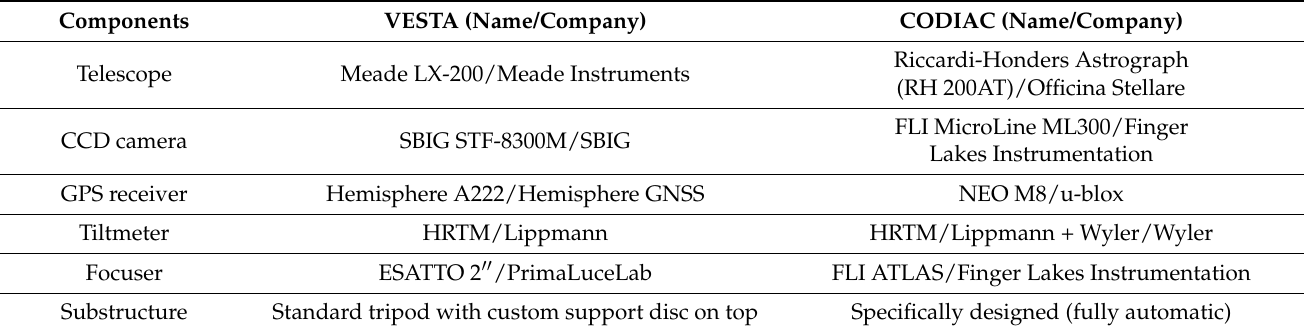
Table 1. The technical components of VESTA and CODIAC.